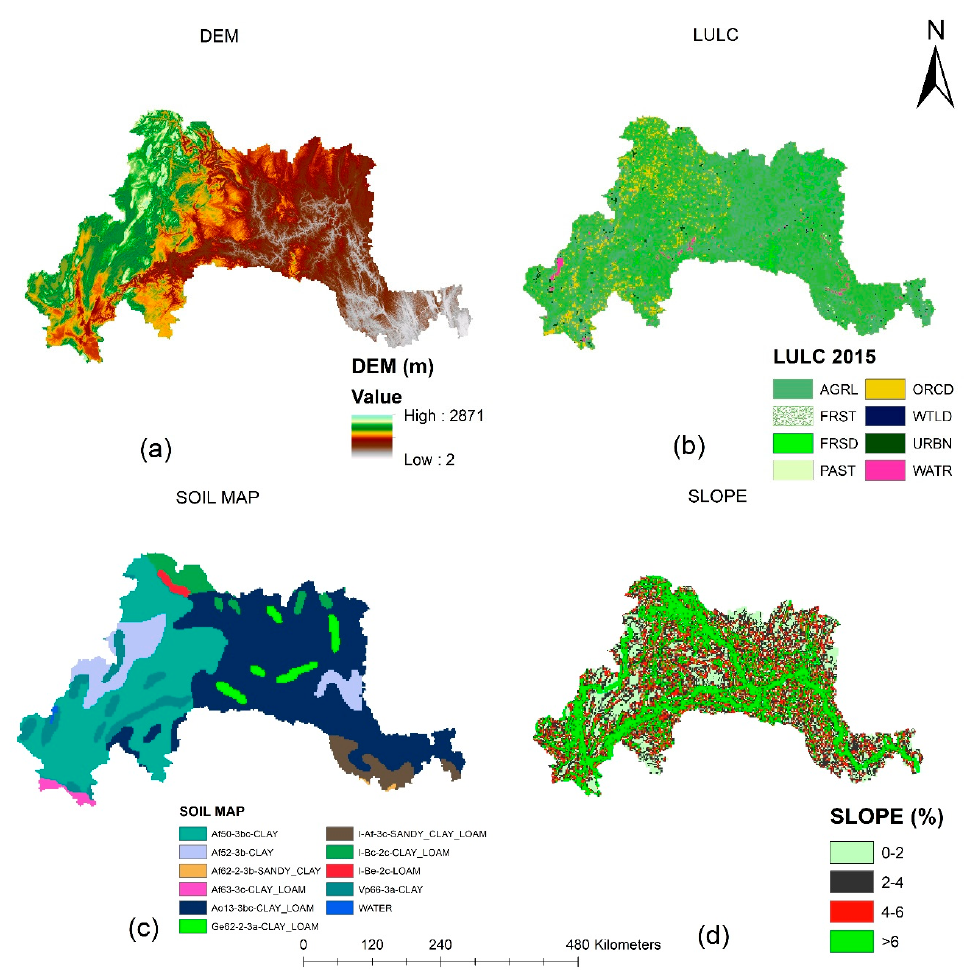
Figure 2. ( a ) Digital elevation model (DEM), ( b ) Land use and land cover (LULC) 2015, ( c ) Soil map, and ( d ) Slope map of Upper Xijiang Watershed.